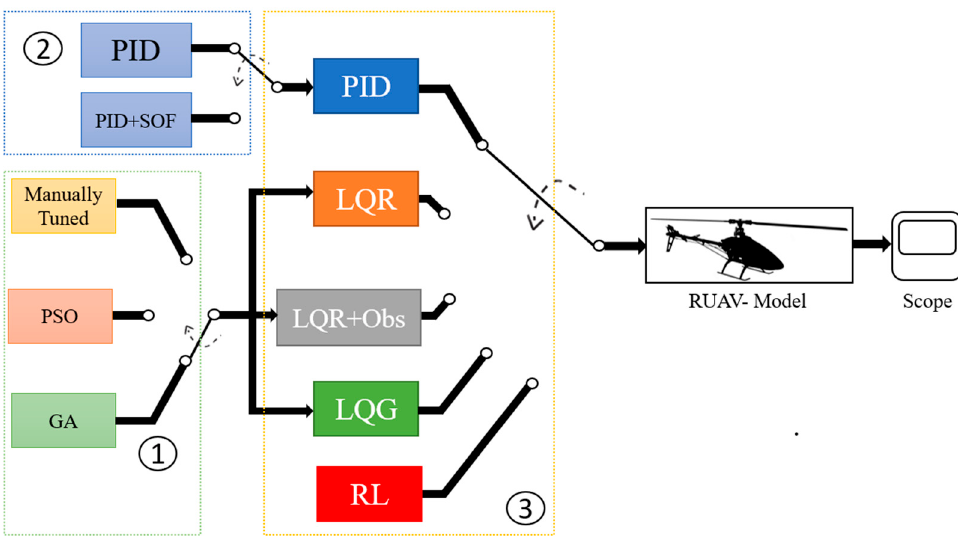
Figure 10. Simulation Environment for RUAV control schematic. The functions are as follows: 1: Allows for switching between different tuning methods for the selected controller. 2: Allows for switching between classic PID and PID controller with Static Output Feedback to enhance response. 3: Allows the vehicle model to be configured to each of the controllers where their responses can be analyzed in the scope.